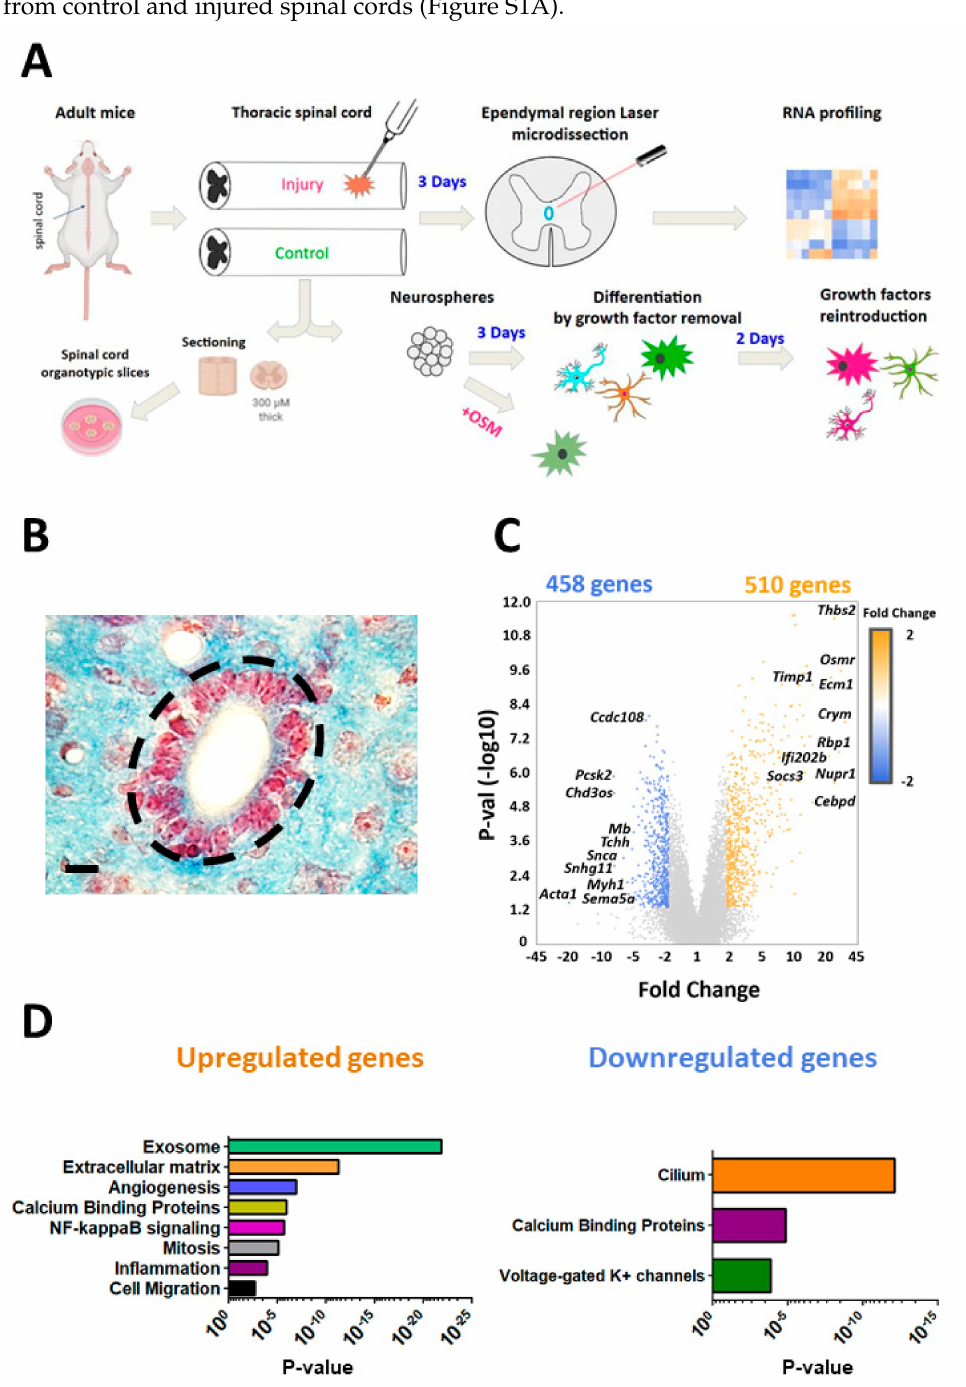
Figure 1. Bioinformatics analysis of ependymal gene expression in SCI. ( A ): Schematic overview of main article steps and techniques. ( B ): Mouse spinal cord ependymal region. Ependymal cell nuclei (thoraco-lumbar level) are stained in red with neutral red dye. Surrounding parenchyma is stained in blue with luxol fast blue. The microdissected area is delimited with black dashed lines. ( C ): Volcano plots of genes whose expression are dysregulated after injury in the ependymal region (fold change ≥ 2 or − 2). Top10 up and downregulated genes are indicated. ( D ): Selection of Gene Ontology analysis for up- and down-regulated genes with p -values. Comprehensive gene ontology analysis is provided on Table